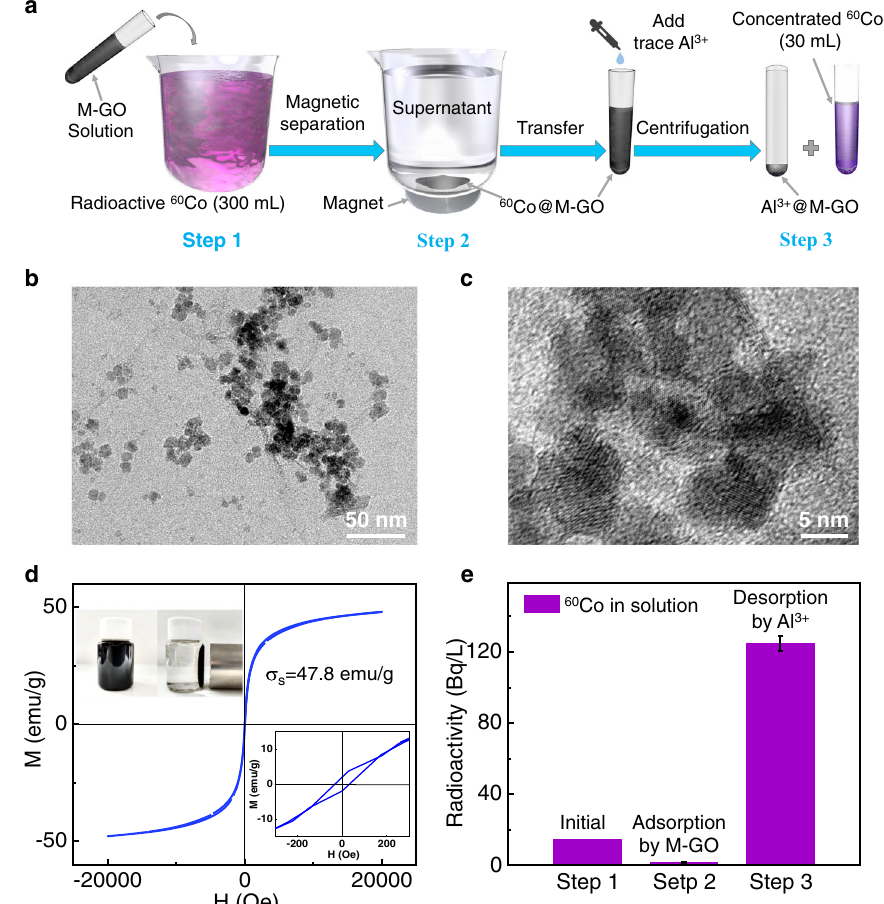
Fig.1|Enrichmentofradioactive 60 Cofromthesolutionbythecontrollableion adsorption and desorption on M-GO. a Schematic of 60 Co enrichment. b TEM image and c high-resolution TEM image of M-GO. d Magnetization curve at room temperature(298K)fortheM-GO.InsetisaphotographofseparationofM-GOwith